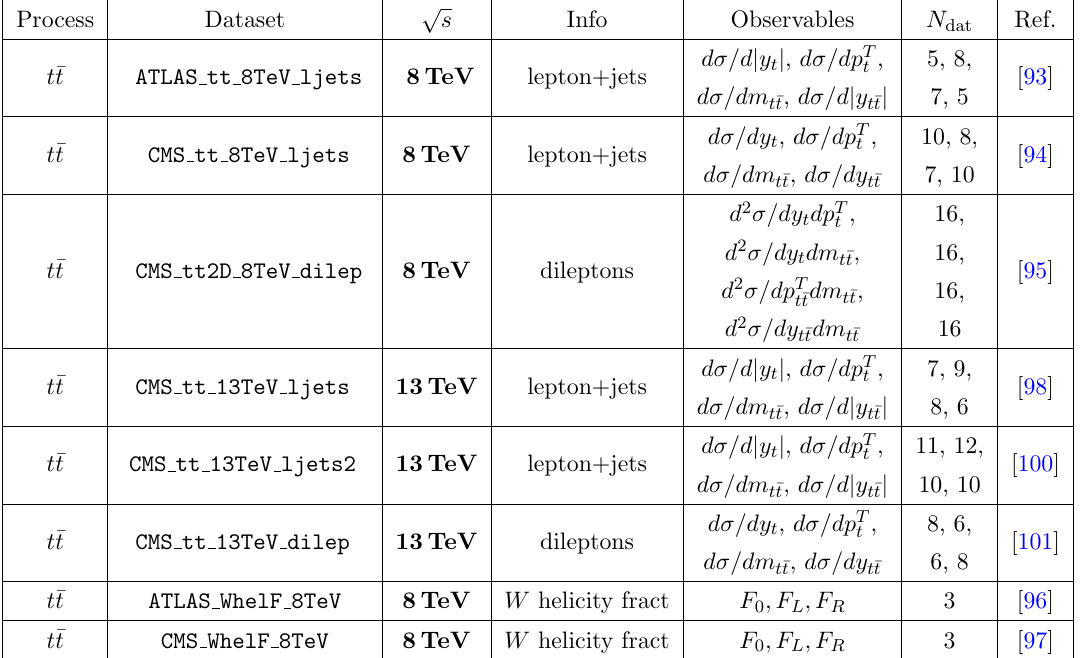
Table 2 . The experimental measurements of inclusive top quark pair production at the LHC considered in the present analysis to constrain the coe(cid:14)cients of the SMEFT dimension-6 operators in the top sector. For each dataset, we indicate the type of process, the dataset label, the center of mass energy p s , the (cid:12)nal state or the speci(cid:12)c production mechanism, the available observables, the number of data points N dat , and the publication reference. Most distributions are statistically correlated among them and one needs to be careful to avoid double